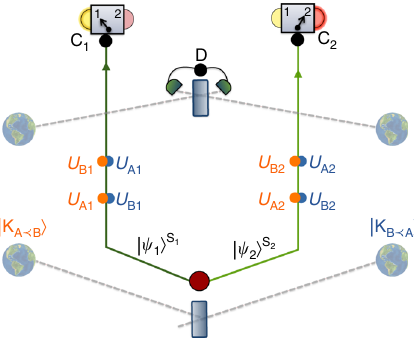
Fig. 3 Schematics of a protocol for a violation of Bell ’ s inequalities for (cid:5) (cid:5) (cid:6) (cid:6) (cid:5) (cid:5) S 1 ψ S 2 temporal order. Systems S 1 , S 2 are prepared in a product state ψ 1 2 and sent to space-like separated regions. One pair of agents performs unitary operations U , U on S 1 at the correspondingly marked space-time A 1 B 1 events; another pair acts on S 2 with unitary operations U and U . Each A 2 B 2 operation is applied only once, at an event de fi ned by the speci fi c proper time of the local clock of the agent. A massive body is prepared in a i and j K i , which de fi ne superposition of two con fi gurations j K B (cid:2) A A (cid:2) B i , the different causal structures for future events. For the amplitude j K A (cid:2) B i = 1, 2 applied on S operations U i are in the causal past of the operations A i U i (blue dots). The operations can (orange dots); and vice versa for j K (cid:5) (cid:5) (cid:6) (cid:6) B i B (cid:2) A (cid:5) (cid:5) S i is orthogonal to U S i (for both i = 1 U ψ U ψ be chosen such that U i i A i B i B i A i and i = 2), resulting in a maximally entangled fi nal state. Bell measurements are performed at events C 1 and C 2 on S 1 and S 2 , respectively. At event D the mass is measured in a superposition basis. Conditioned on the outcome of this measurement, the results of the measurements at C 1 , C 2 can maximally violate Bell ’ s inequalities, which would not be possible if the order of events was classical (even if